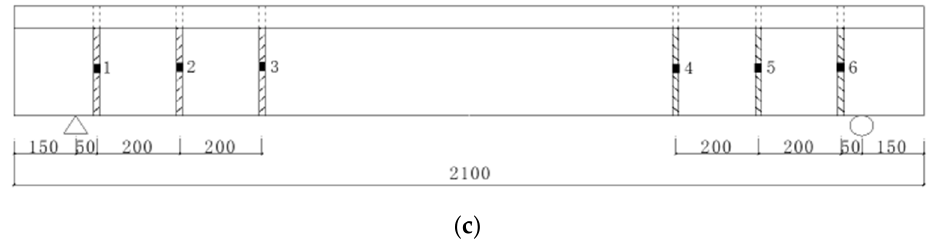
Figure 2. Strain gauge arrangement of FRPs. ( a ) FRP spacing 100 mm; ( b ) FRP spacing 150 mm; ( c ) FRP spacing 200 mm.